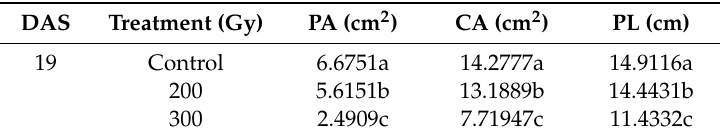
Table 3. Validation experiments to measure multiple phenotypes with gamma dosages of 200 and 300 Gy. Values in the same column followed by a di ff erent letter are significantly di ff erent ( p < 0.05). PA: projected area, CA: convex hull area, PL: perimeter length.